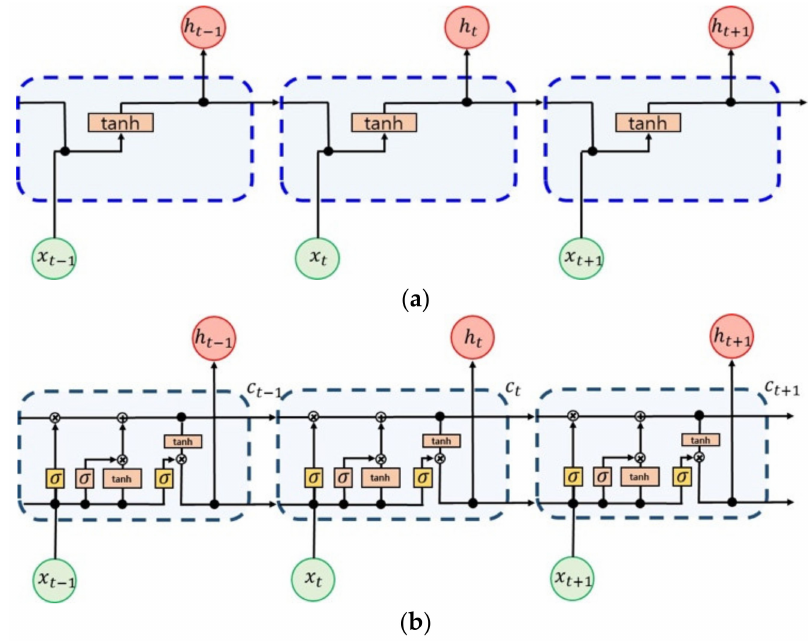
Figure 6. Comparison of ( a ) RNN algorithm and ( b ) LSTM